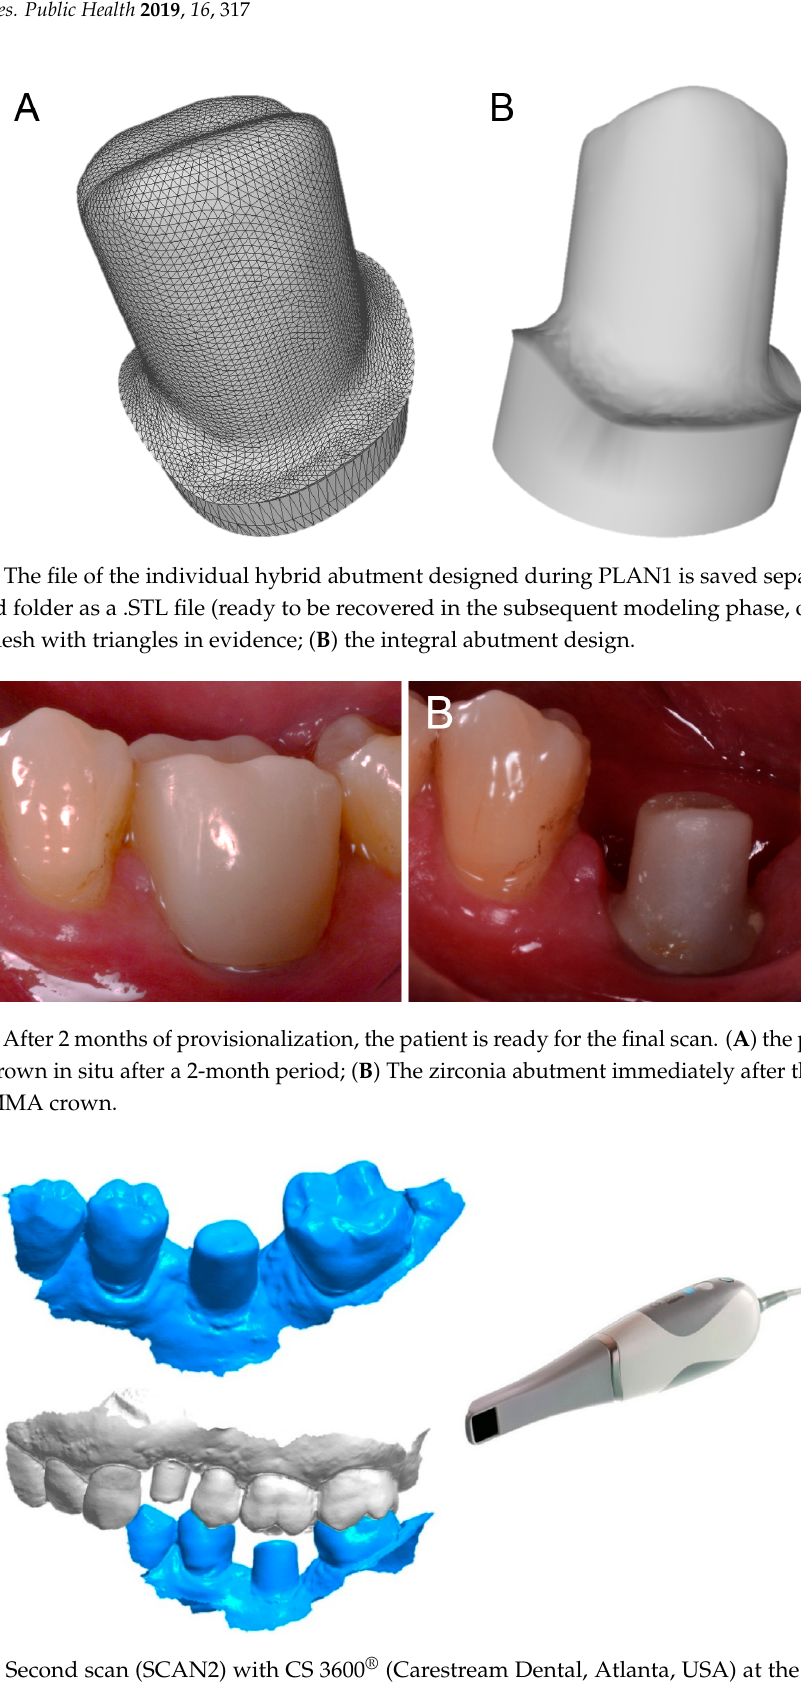
Figure 7. Second scan (SCAN2) with CS 3600 ® (Carestream Dental, Atlanta, USA) at the end of the provisionalization. ( A ) the actual position of hybrid abutment position is captured intraorally, without taking care of the margin line that is clearly subgingival; ( B ) the relationship with the opposing arch.